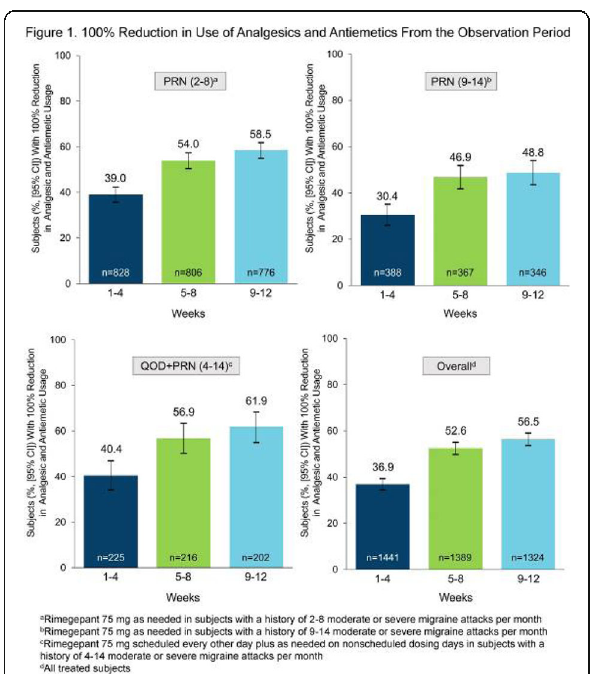
Fig. 1 (abstract P0271). See text for description